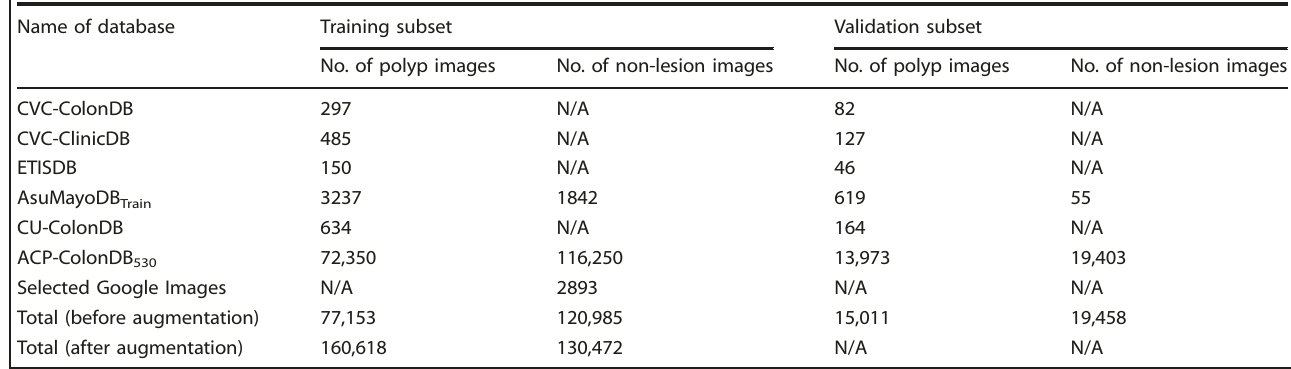
Table 3. Summary of the number of images used for training and validating